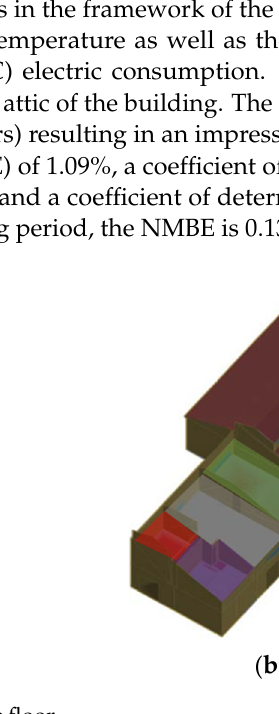
Figure 2. nZEB model ( a ) ground floor; ( b ) attic